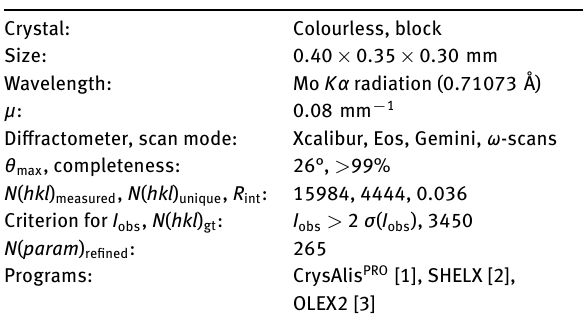
Table 1: Data collection and handling.